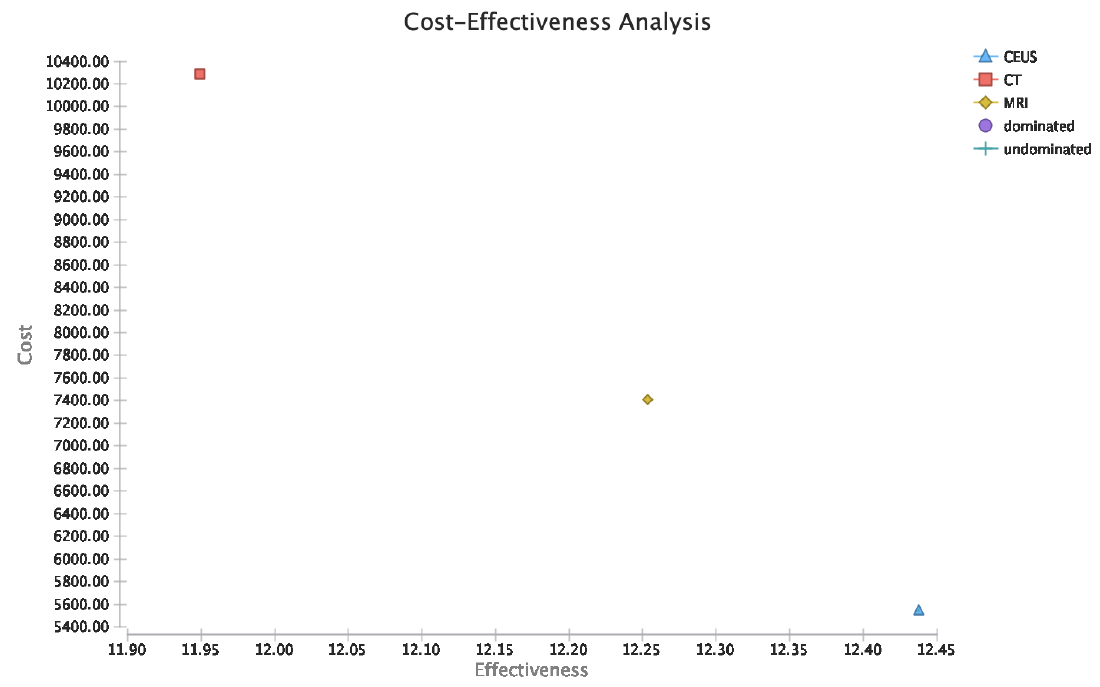
Figure 1. Cost-effectiveness analysis.